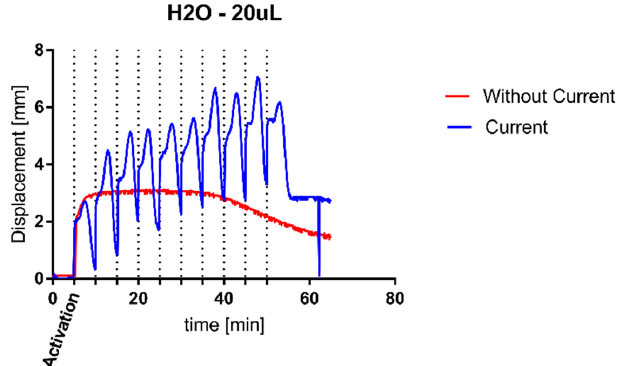
Figure 6. Activation/deactivation time of paper-beam for 20 µ L distilled water.